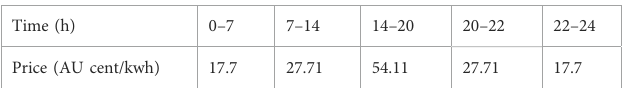
TABLE 2 Australian power price